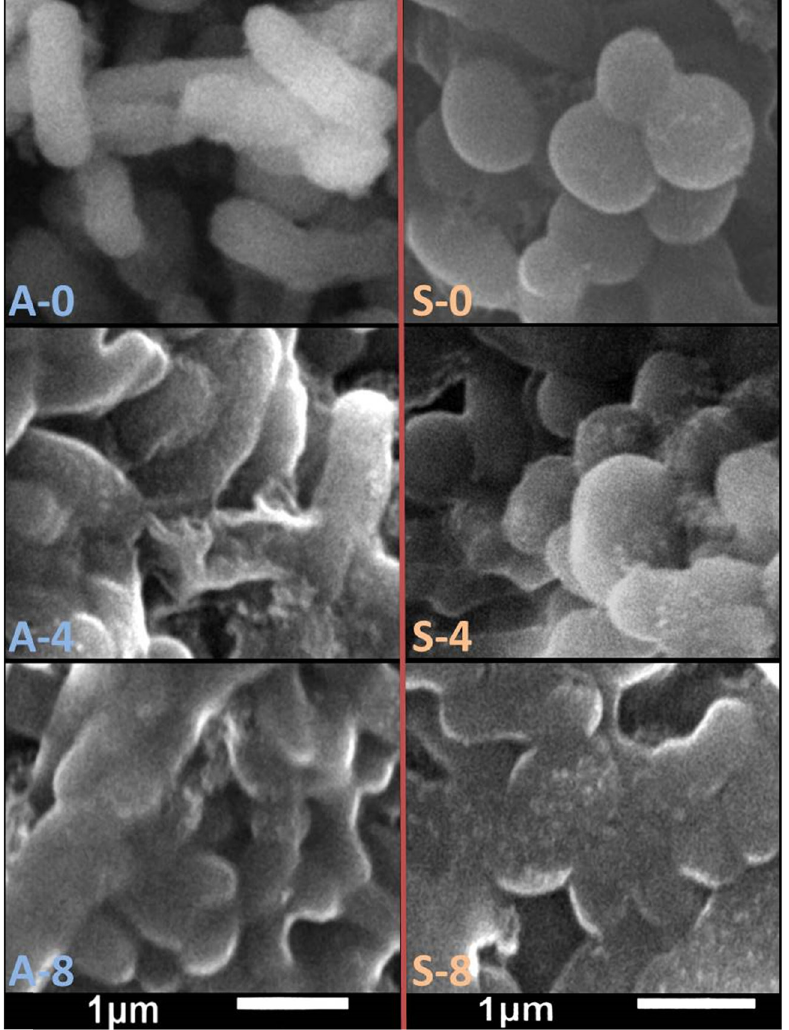
Figure 3: Scanning microscopy images of A. hydrophila ( A ) and S. aureus ( S ) treated with garlic/thyme oil - CS/ALG NC for 0, 4, and 8